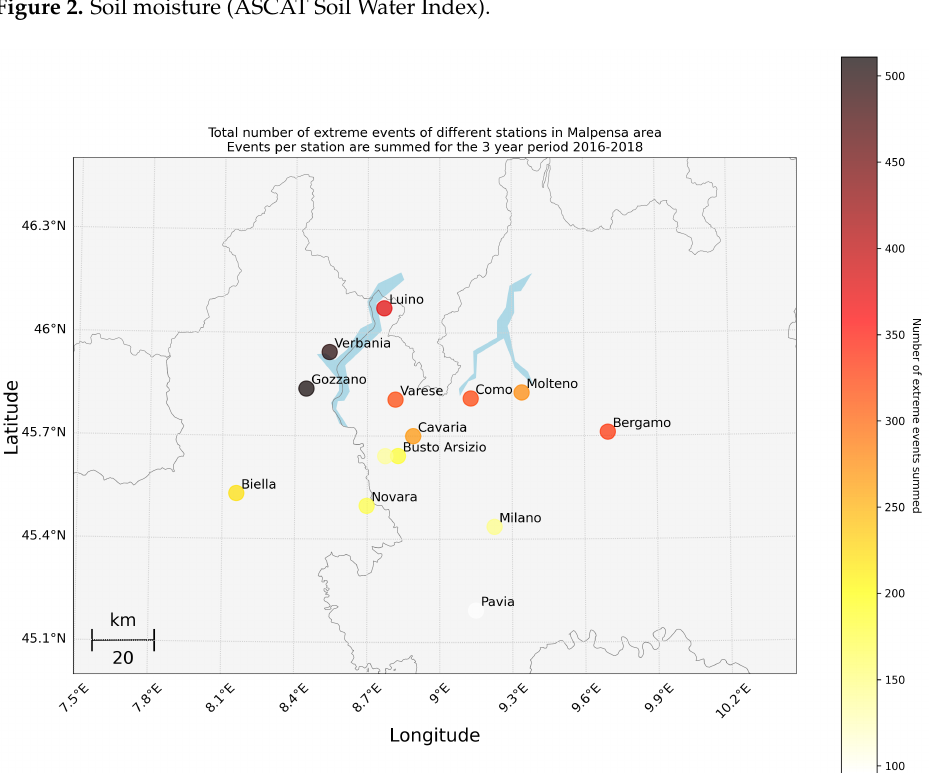
Figure 3. Total number of extreme events for the 3 years period 2016–2018, for each meteorologi- cal